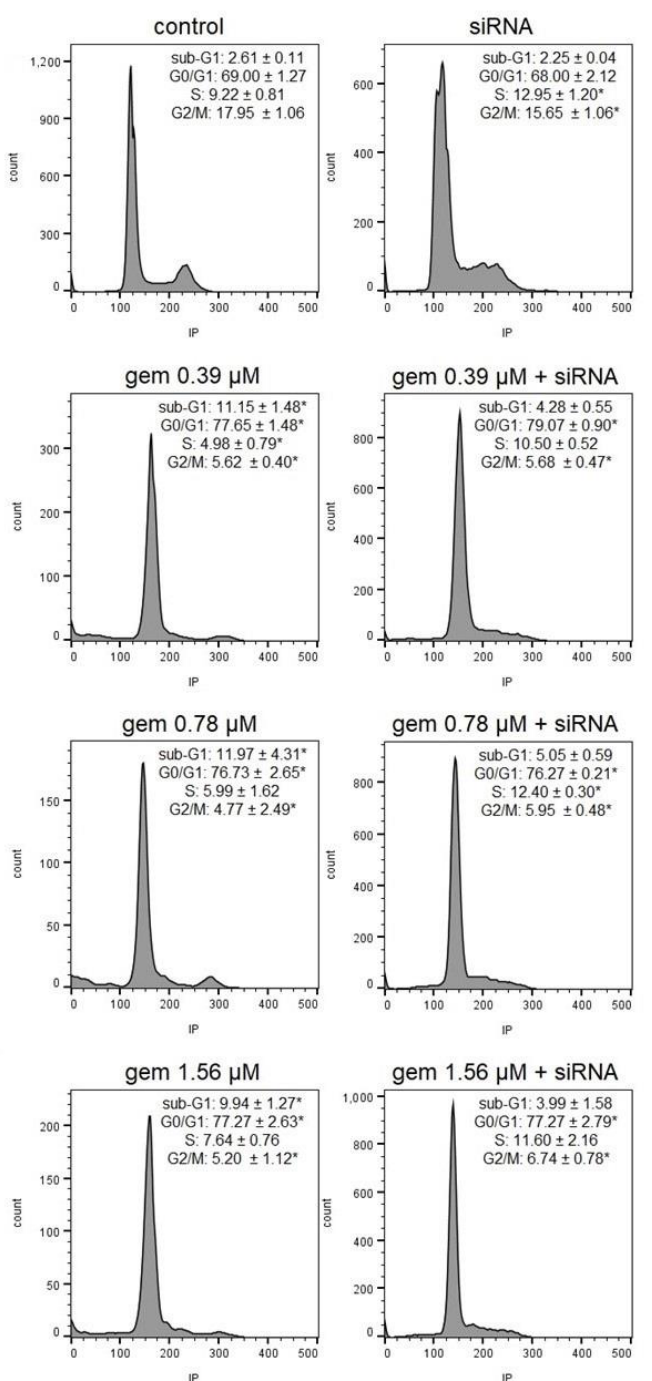
Figure 6. Representative histograms and percentages of UM-UC-3 cells in each phase after treatment with gemcitabine, siRNA JHDM1D-AS1 , or gemcitabine combined with siRNA JHDM1D-AS1 . Control: untreated cells; gem: gemcitabine; IP: propidium iodide. * p < 0.05 compared to control.